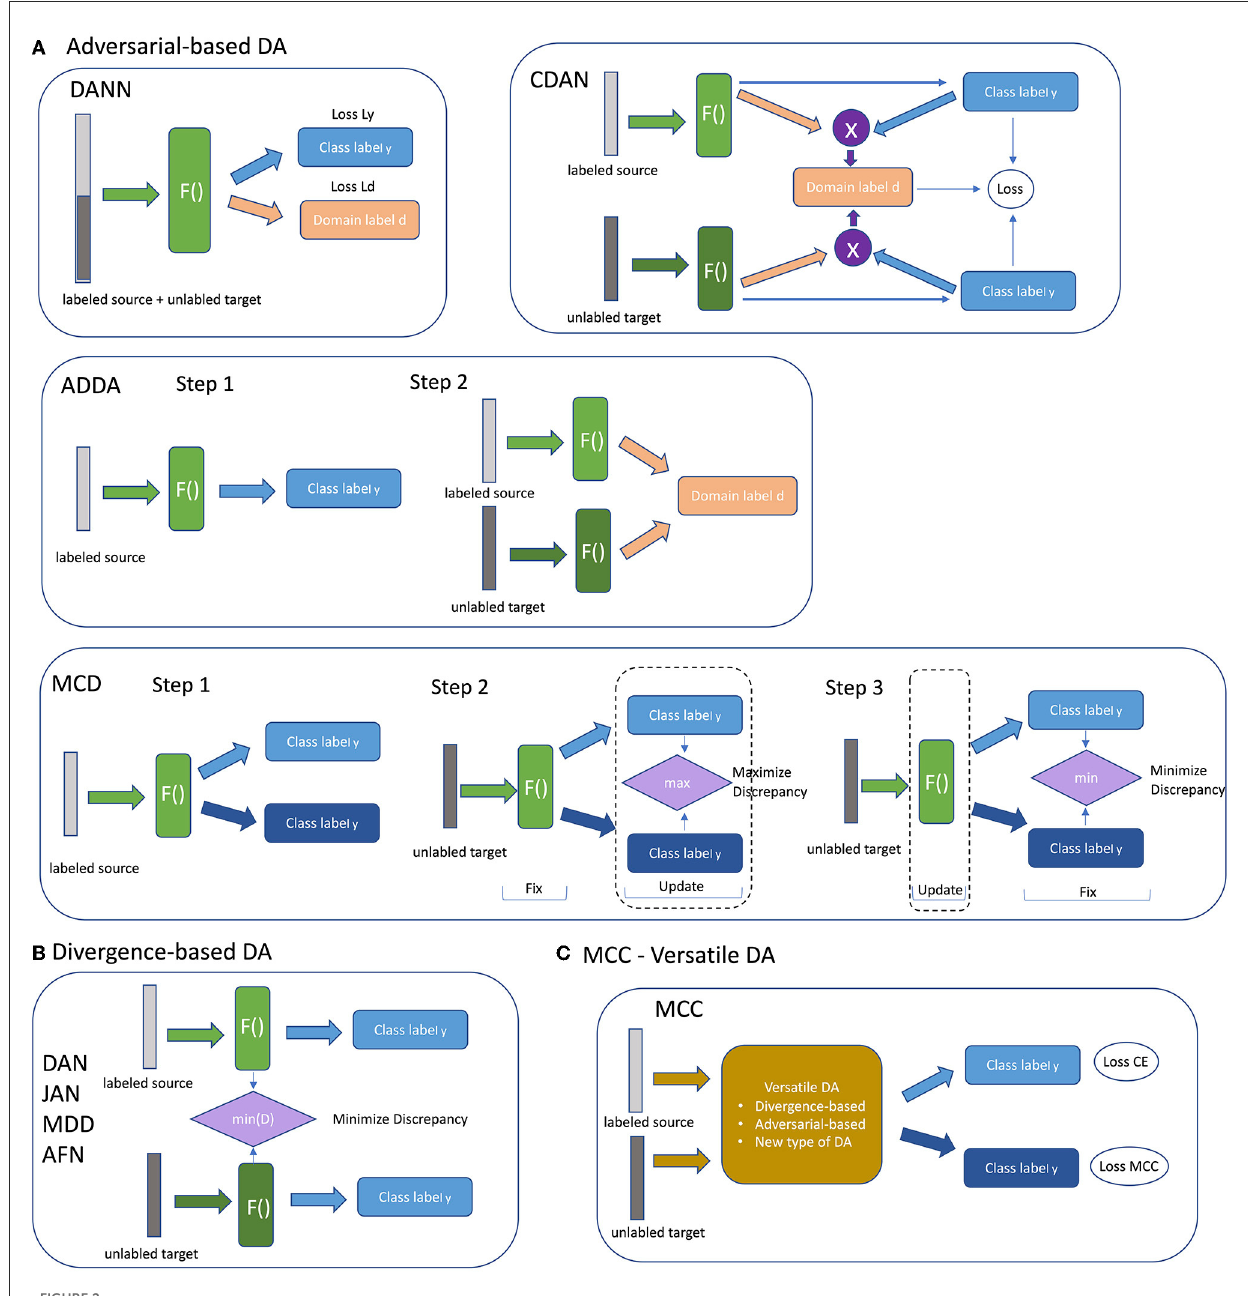
FIGURE2 Schematic representation of different types of DA models. (A) Adversarial-based DA models. (B) Divergence-based DA models. (C) MCC with Versatile DA models.